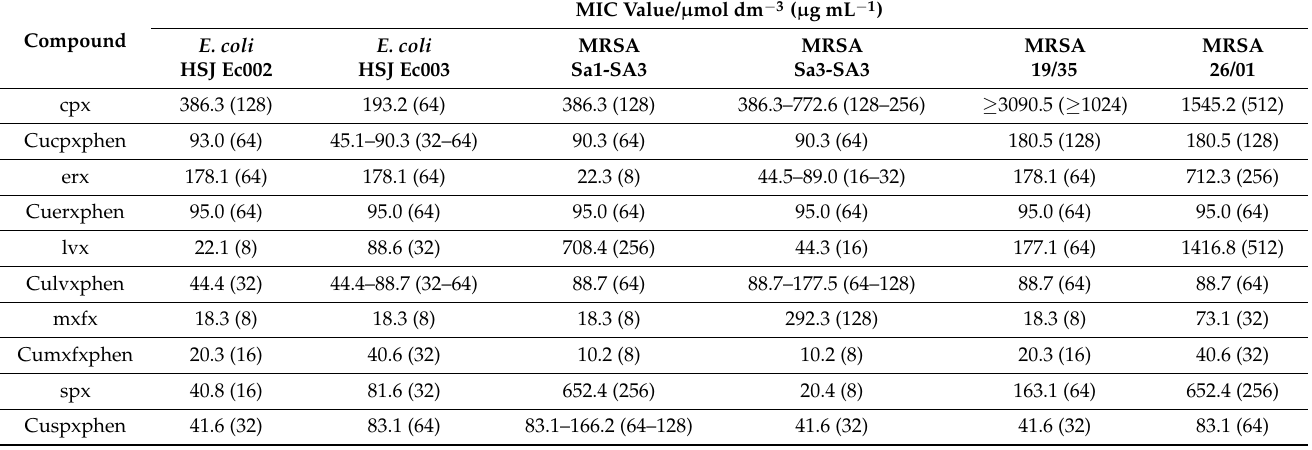
Table 5. Minimum inhibitory concentration (MIC) values of several free FQs and metalloantibiotics (CuFQphen) against multidrug-resistant (MDR) strains of E. coli (HSJ Ec002 and HSJ Ec003) and MRSA (Sa1-SA3, Sa3-SA3, 19/35 and 26/01), from